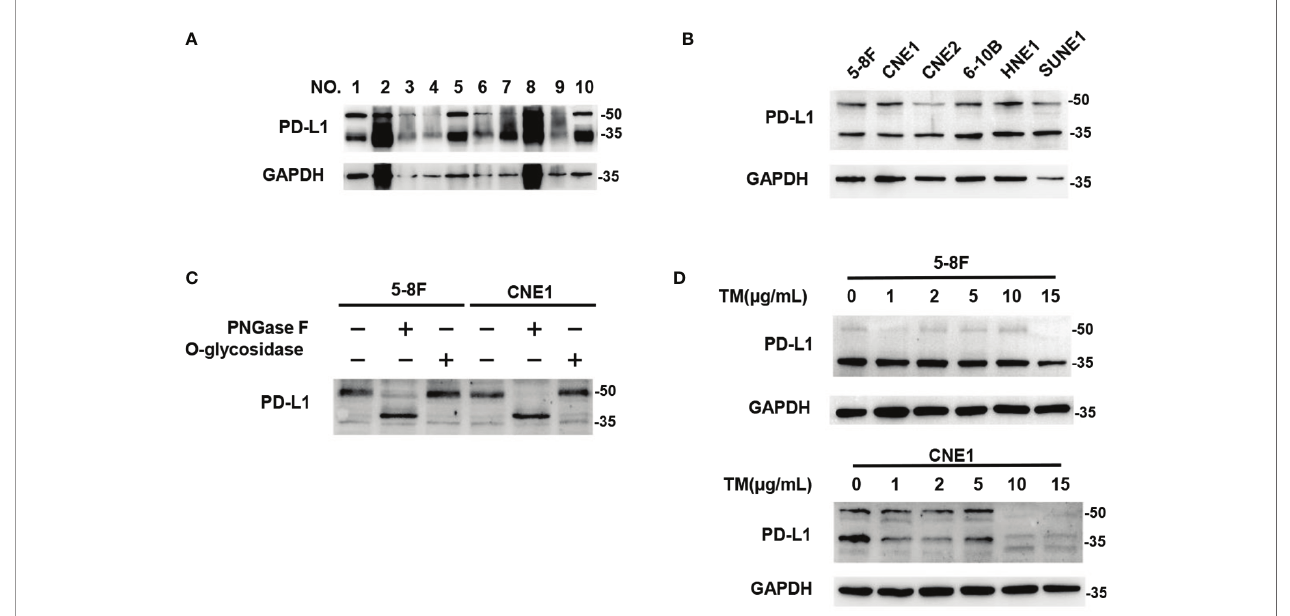
FIGURE 1 | PD-L1 was N-glycosylated in Nasopharyngeal Carcinoma. (A) Western blot analysis of PD-L1 in NPC patient samples. (B) Western blot analysis of PD- L1 in 6 NPC cells including 5-8F, CNE1, CNE2, 6-10B, HNE1, SUNE1. (C) Glycosylation pattern of PD-L1 protein in 5-8F and CNE1 cells. Cell lysates were treated with PNGase F or O-glycosidase and analyzed by western blot analysis. (D) Western blot analysis of PD-L1 in 5-8F and CNE1 cells treated by Tunicamycin (TM) with increasing